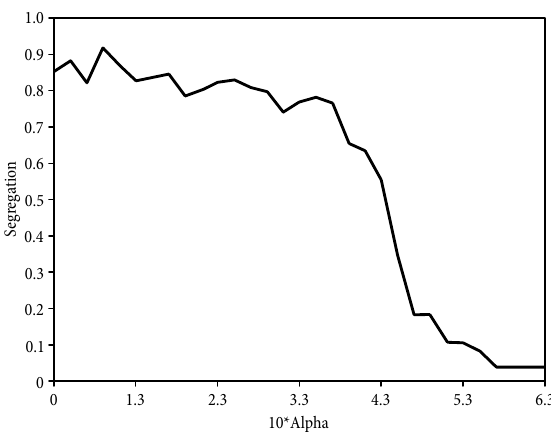
Fig. 6. Segregation equilibria with n